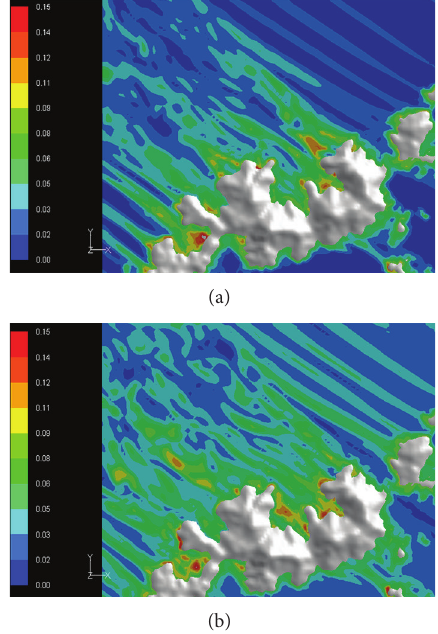
Figure 11: Vorticity field at a height of 220 m above sea level at 31 minutes for NS (a) and SS